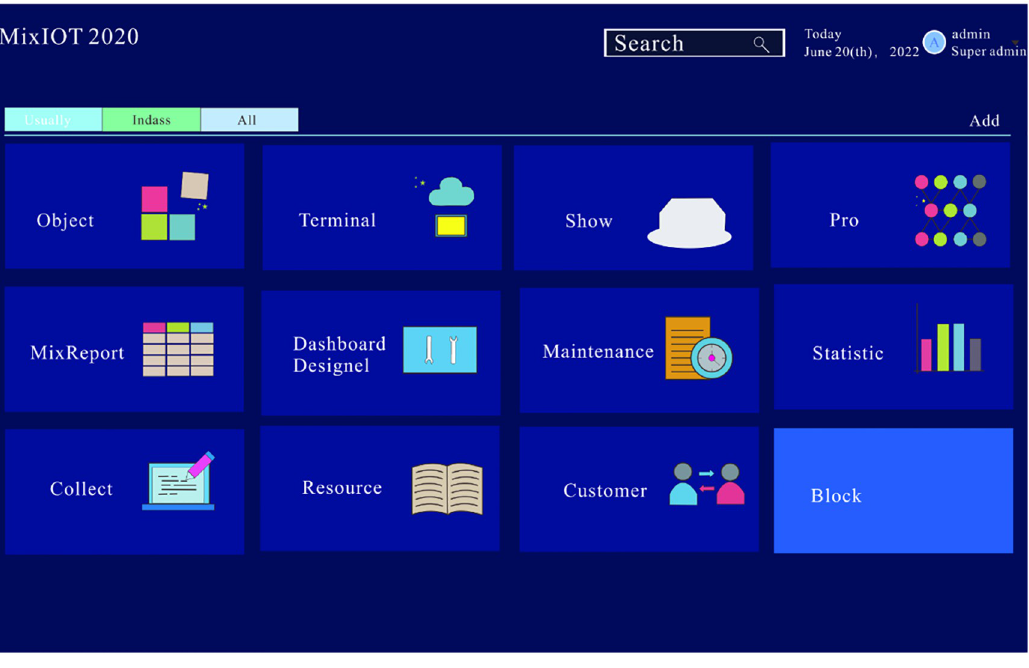
Fig 5. MixIoT platform.